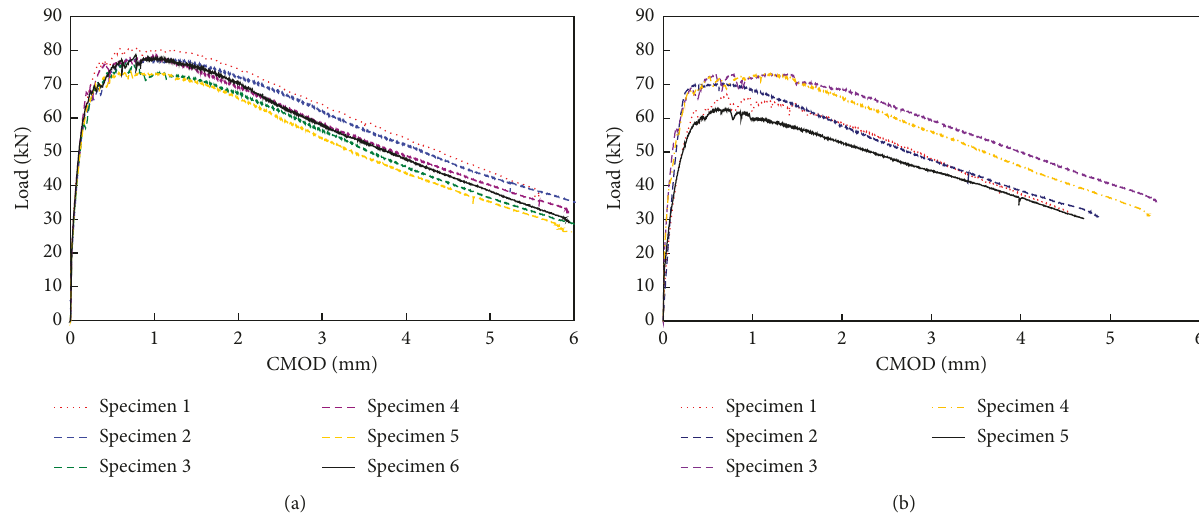
Figure 7: Comparison of the load-CMOD curves of the F20 series mixtures. (a) F15-S-L130 mixture. (b) F15-H mixture. Table 6: Comparison of the test results and estimation from the regression analysis of the tensile strength Number of Number of Mixture Batch specimens